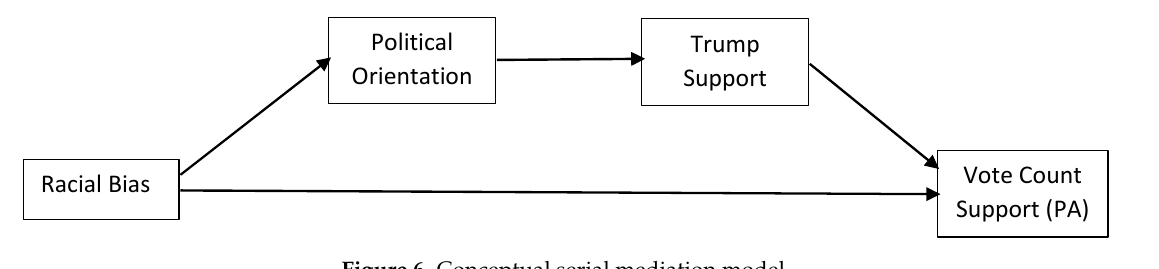
Figure 6. Conceptual serial mediation model.